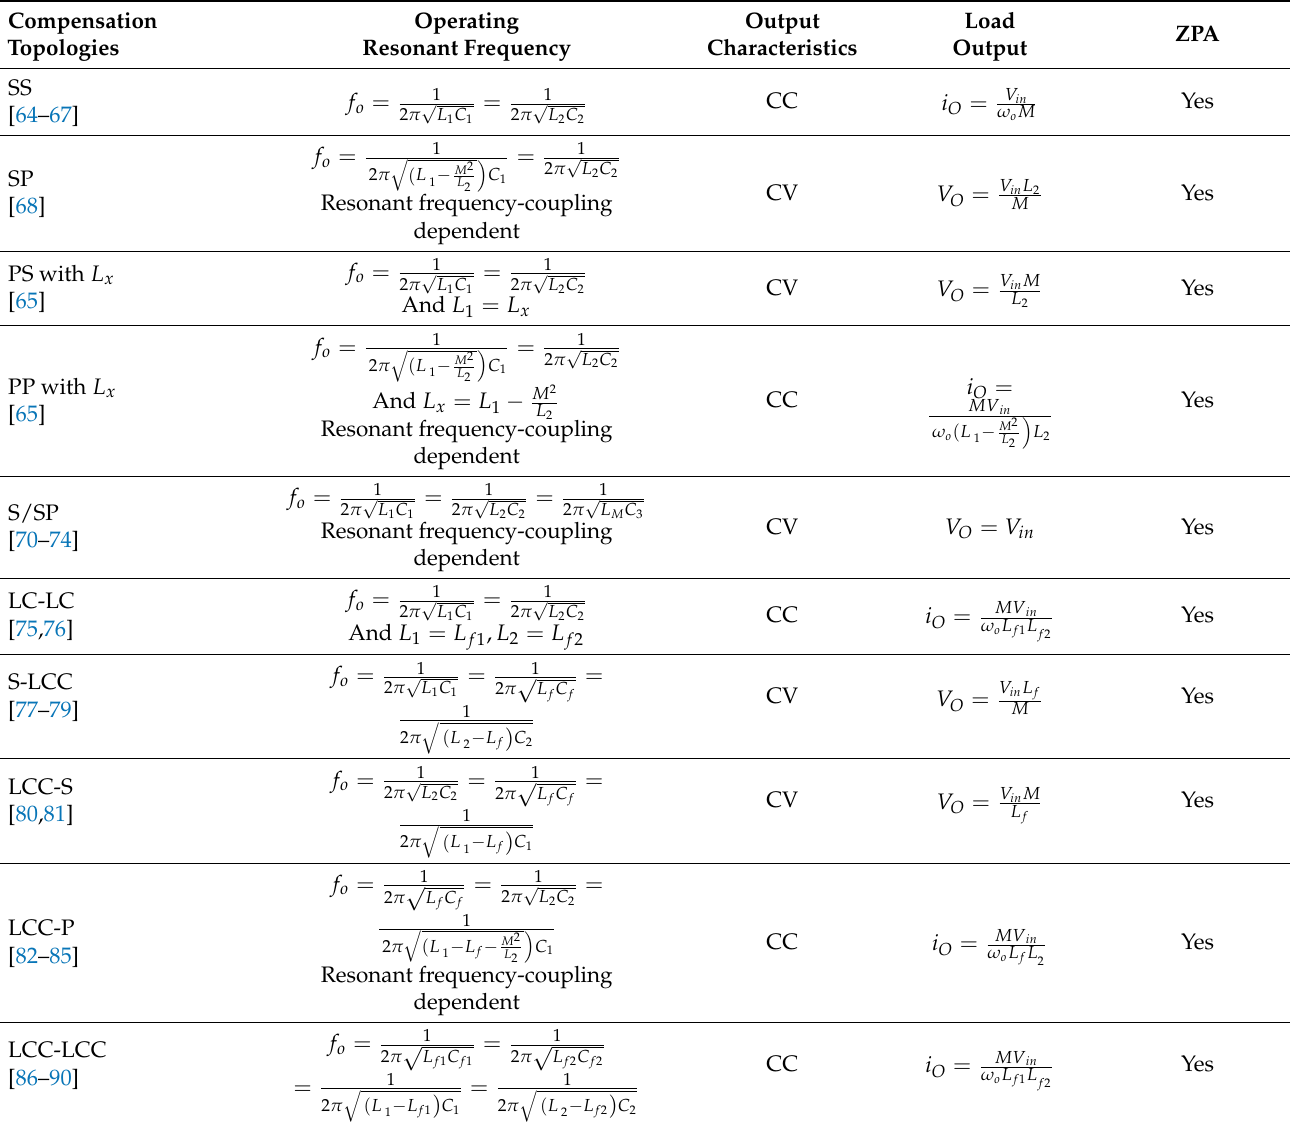
Table 3. Load-independent characteristics of different compensation